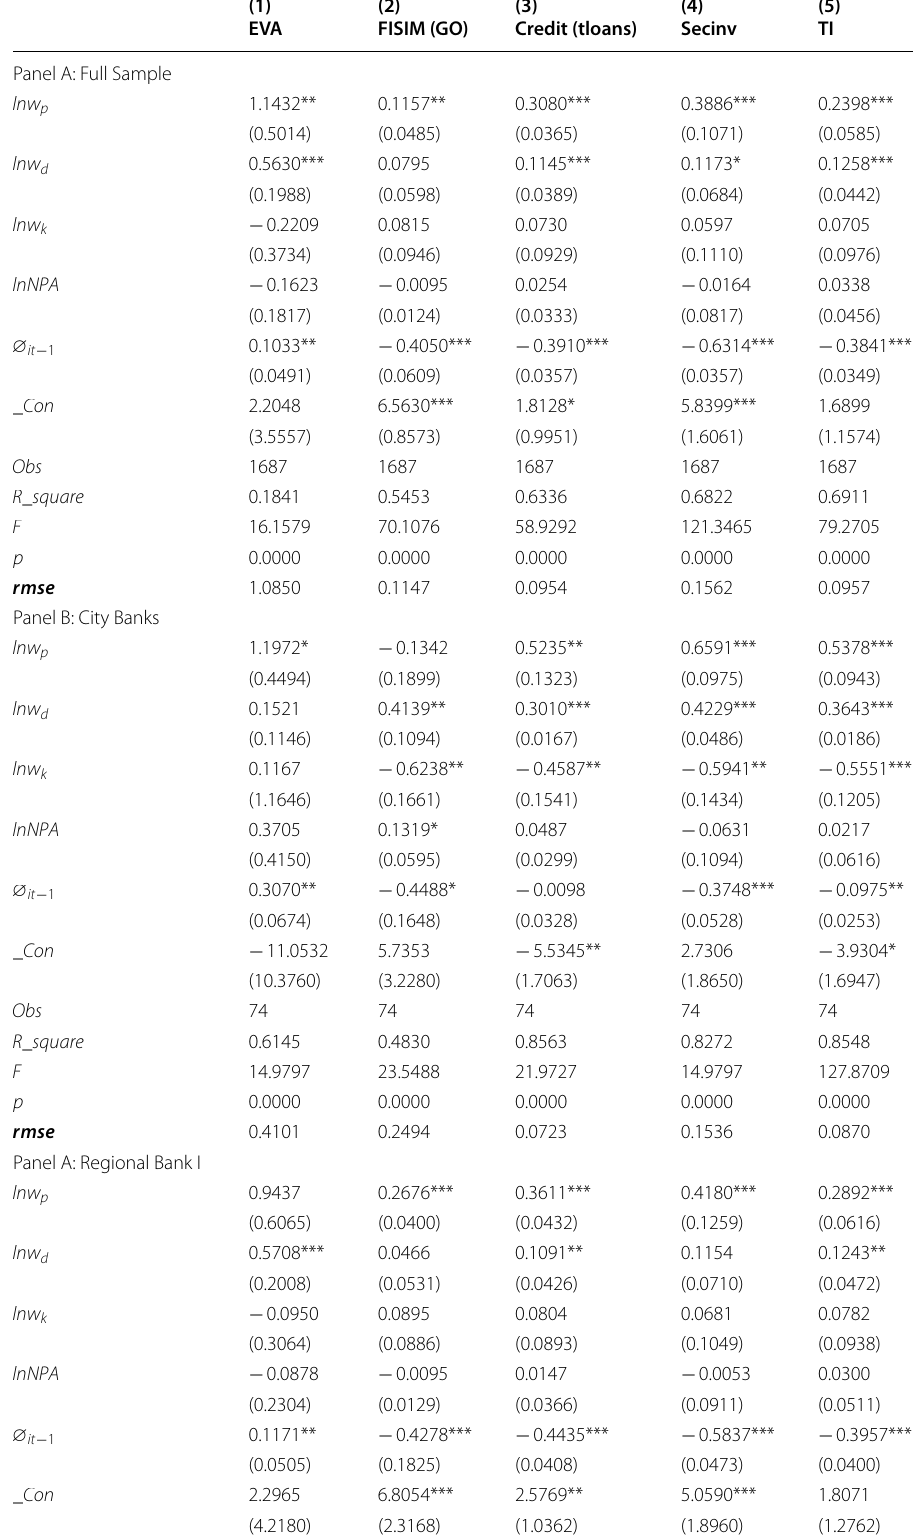
Table 2 Estimated regression results of the learning model (Eq.